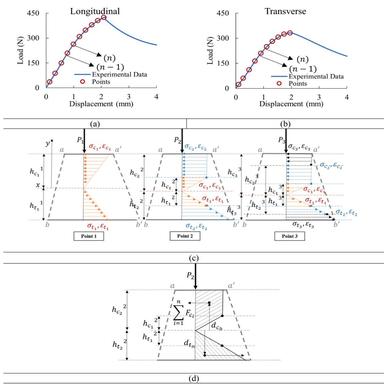
Discretization of load-displacement curves in (a) longitudinal (b) transverse directions, which were used to calculate the evolution of bending stiffness as the deformation progresses. (c) A schematic of compressive and tensile stresses and the change in the location of the neutral axis as the three-point bending progresses. In the beginning, both tensile and compressive sections are elastic and symmetric (Point 1). Then, when the section reaches plastic stresses, compressive and tensile stresses evolve dif